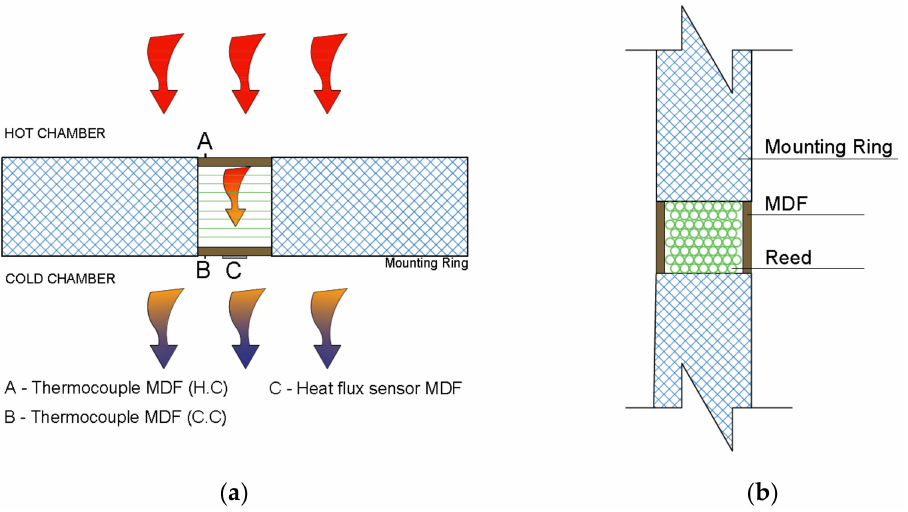
Figure 6. Set up of reed panel in hotbox test: ( a ) horizontal view and ( b ) vertical view. The temperature difference between the hot and cold chambers was maintained at around 10 ◦ C. The tests were carried out by the thermal flux meter methodology, according to ISO 9869-1:2014 [36], where the heat flux was measured through a heat flux sensor installed in the central part of the reed panel and the temperature was measured by four thermocouples (two in each chamber: one in the middle of the chamber and the other on the surface of the reed panel). With the values of the heat flux (q) and the surface temperatures (T) while using Equation (5), it was possible to determine the thermal resistance (Re set ) of the set (reed panel and MDF), where ∆ T is the difference between the surface MDF temperature in the hot and cold chambers.